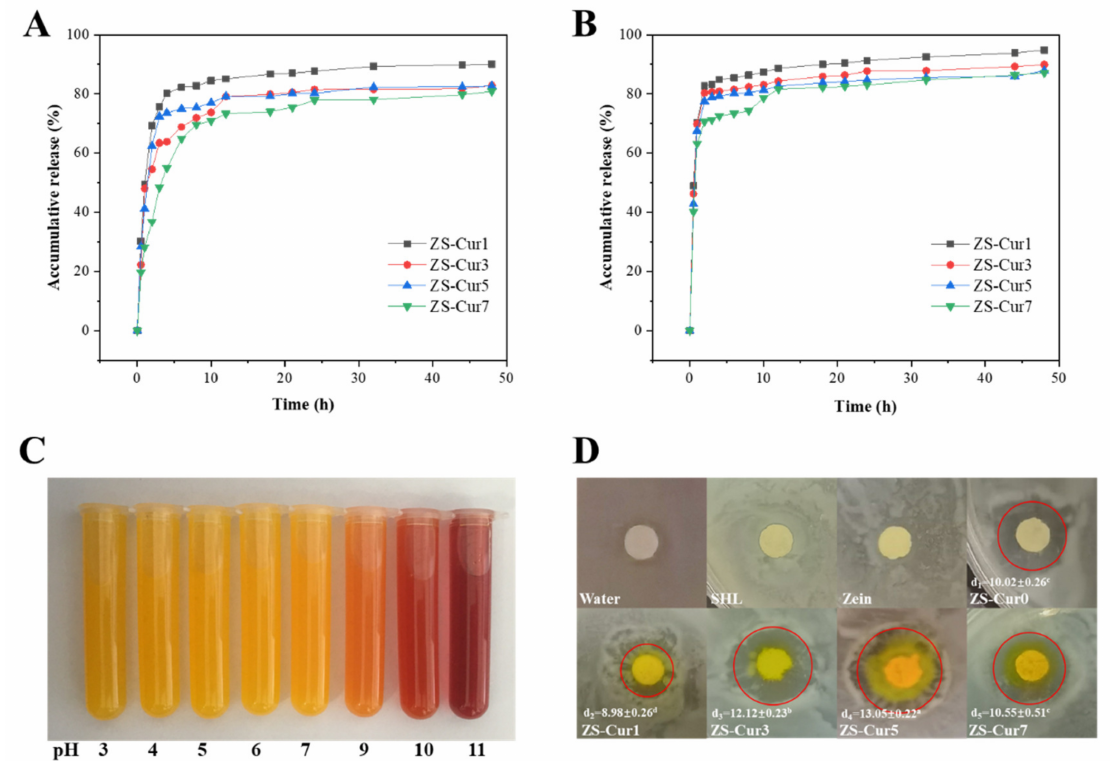
Figure 5. Accumulative release of curcumin from films: ( A ) semi-fatty food simulant medium, ( B ) fatty food simulant medium; ( C ) color changes of curcumin at different pH values, and ( D ) an- tibacterial cycle of zein/shellac